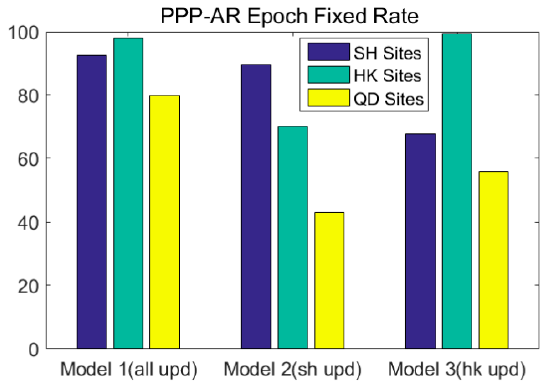
Figure 9. RTPPP-AR average percentage ambiguity fixed rates of different regional stations in different UPD models (reference station coordinates are set to known).